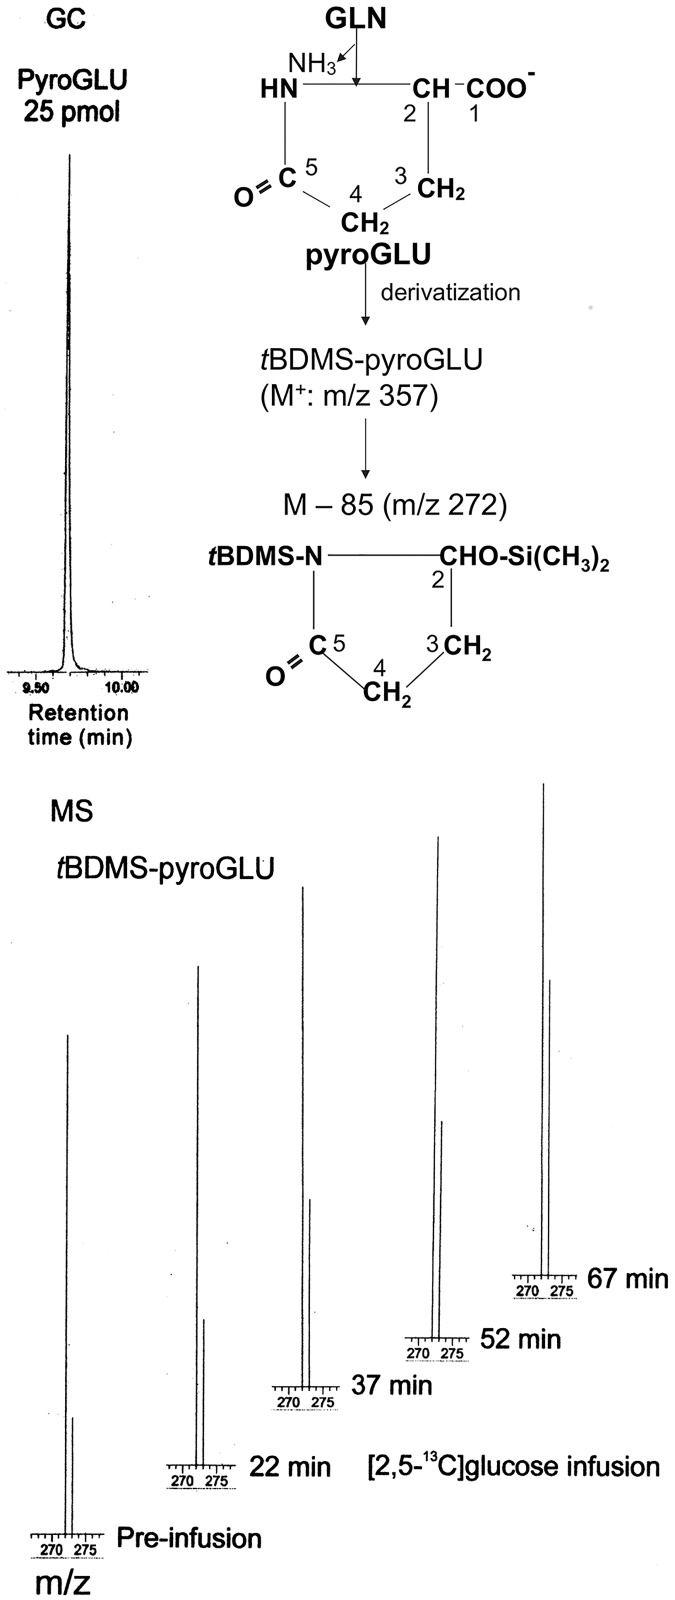
Progressive 13C enrichment of GLNECF during i.v. infusion of [2,5-13C]glucose, as observed by GCMS.Right panel: GLNECF was converted to pyroGLU and derivatized to tBDMS-pyroGLU, which, upon electron-impact ionization, produced fragment ions m/z 300, m/z 272 and m/z 198 as shown in S4 Fig. Left panel: GC chromatogram of 25 pmol of tBDMS-pyroGLU. Bottom panel: mass spectra of tBDMS-pyroGLU derived from GLNECF collected from the ipsilateral hippocampus during i.v. infusion of [2,5-13C]glucose. Progressive 13C enrichment was observed from the increase in the peak area of the m/z 273 ion relative to that of m/z 272 ion. The structure of the fragment ion with m/z 272 is shown at the bottom of the right panel.